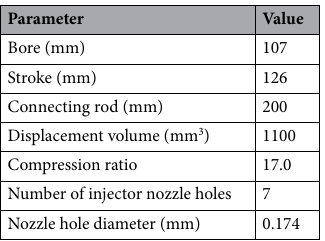
Table 1. Specifications of single-cylinder dual-fuel engine.